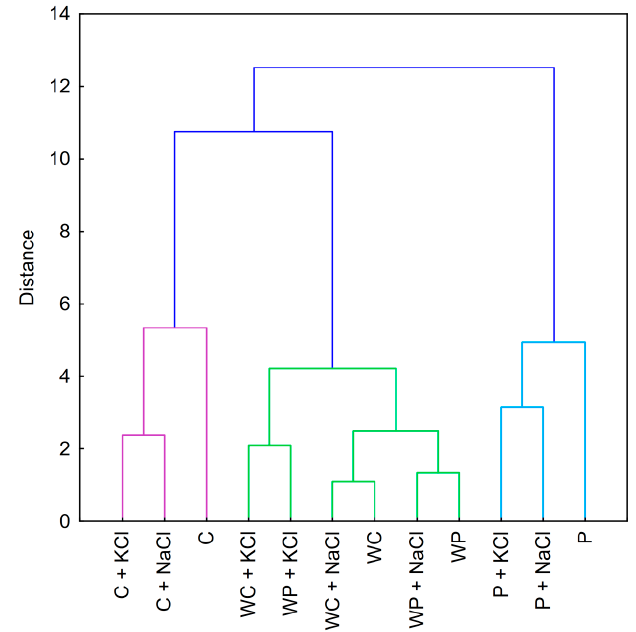
Figure 4. Dendrogram of hierarchical cluster analysis of binary mixtures of 5% native starch pastes with 3% salt. Explanatory notes: P—potato starch; WP—waxy potato starch; C—corn starch; WC—waxy corn starch; NaCl—sodium chloride; KCl—potassium chloride.